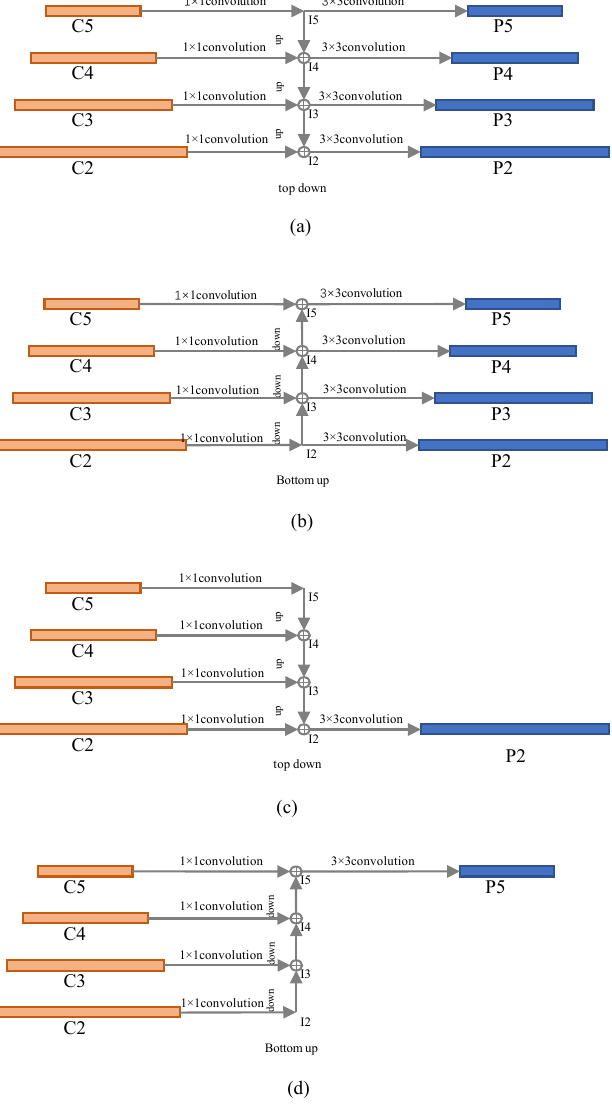
Figure 8. Two strategies of feature pyramid fusion. ( a ) Top-down pyramid fusion. ( b ) Bottom-up pyramid fusion. ( c ) Top-down single-layer fusion. ( d ) Bottom-up single-layer